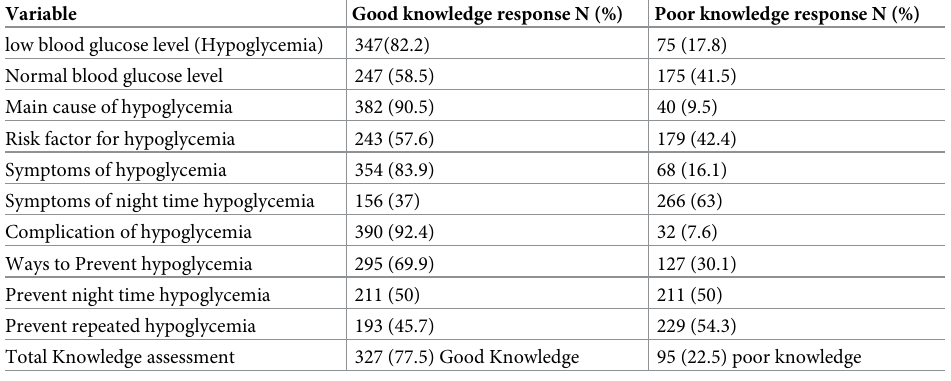
Table 3. Knowledge regarding hypoglycemia prevention among study subjects, UoGRTH, North-west Ethiopia, 2019 (N = 422).